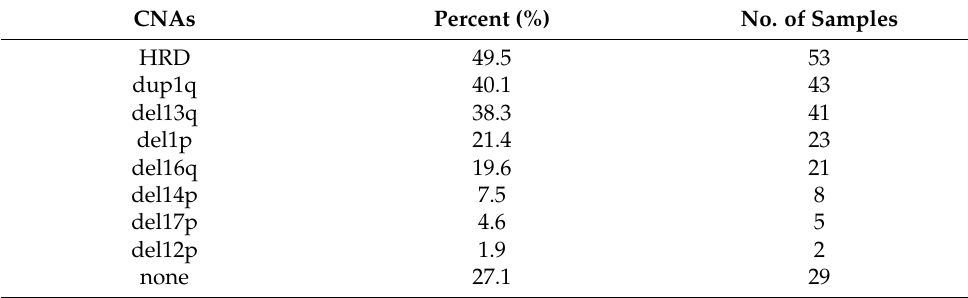
Table 2. Copy number alteration (CNA) frequency in the study